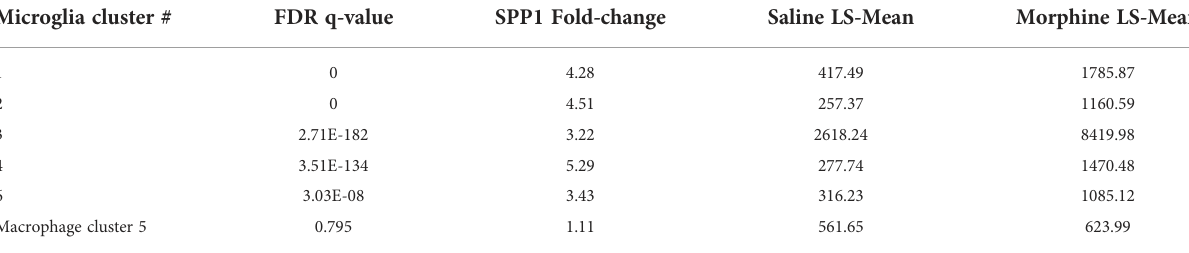
TABLE 3 Morphine effect on SPP1 expression in the brain macrophage and microglia clusters. Microglia cluster